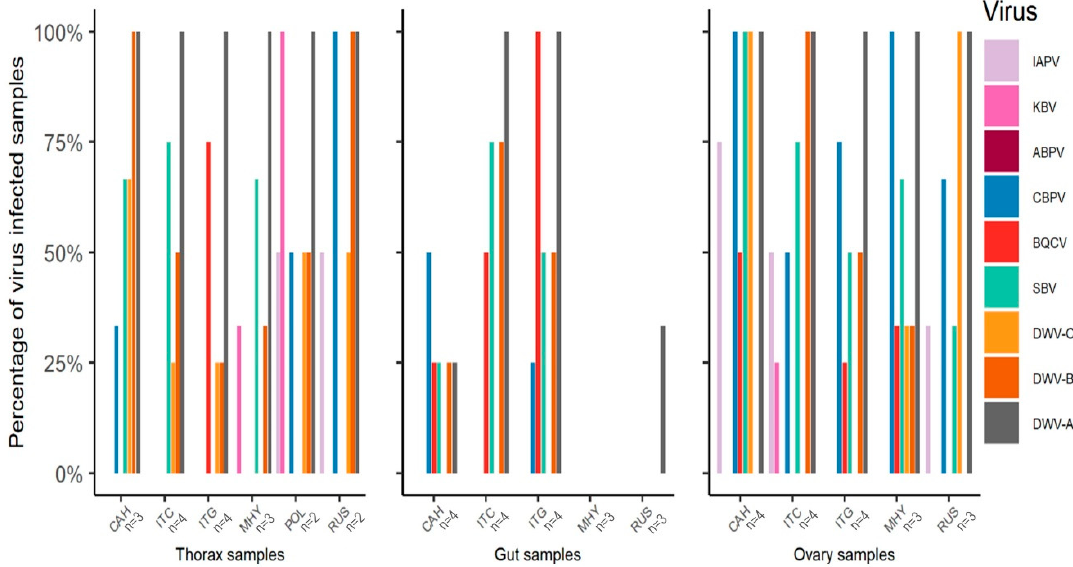
Figure 1. Percentage of samples testing positive for the presence of different viruses in different body parts (thorax, gut, and ovaries). Newly shipped queens from different stocks (ITC = “Italians” from California, ITG = “Italians” from Georgia, CAH = “Carniolans” from Hawaii, MHY = Minnesota “Hygienics”, POL = POL-line, and RUS = “Russians”) were tested for the presence of Israeli acute paralysis virus (IAPV), Kashmir bee virus (KBV), Acute bee paralysis virus (ABPV), Chronic bee paralysis virus (CBPV), Black queen cell virus (BQCV), Sacbrood virus (SBV), Deformed wing virus DWV-A, DWV-B, and DWV-C via RT-PCR. Sample sizes are indicated below the x -axis.